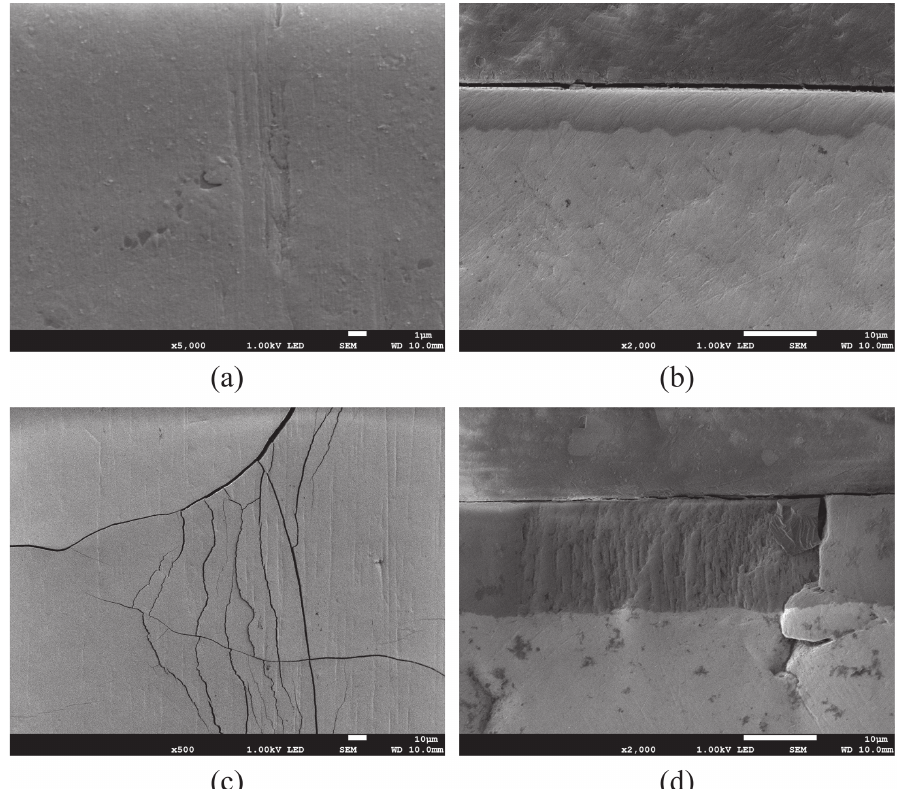
Figure 1: The surfaces (a, c) and cross-sections (b, d) of the Zircaloy-2 alloy oxidized at 700°C (a, b) and 900°C (c, d) for 30